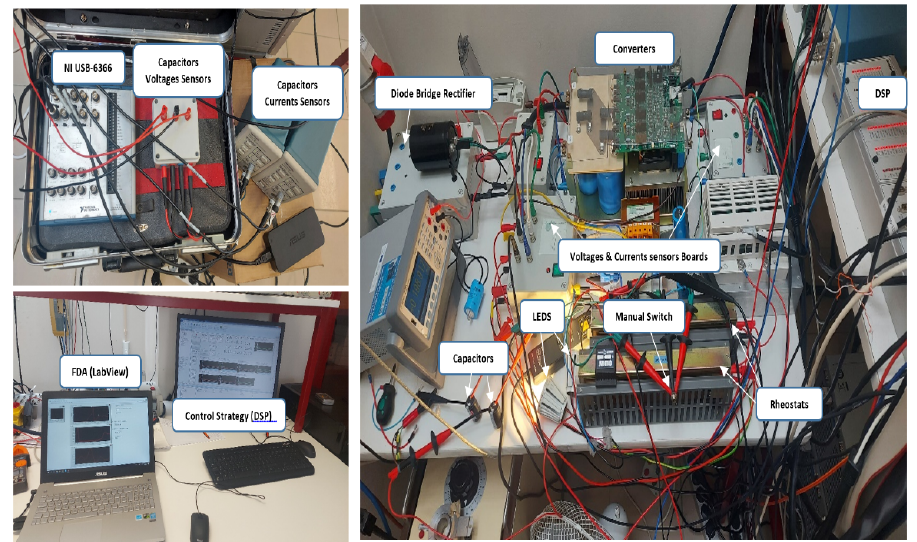
8 of 15 Figure 6. The proposed FDA.